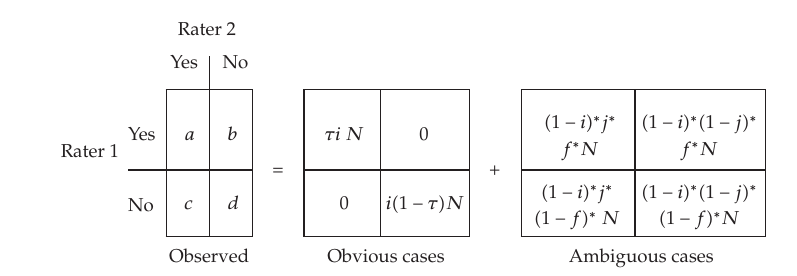
Figure 2: Two-rater data generating mechanism.